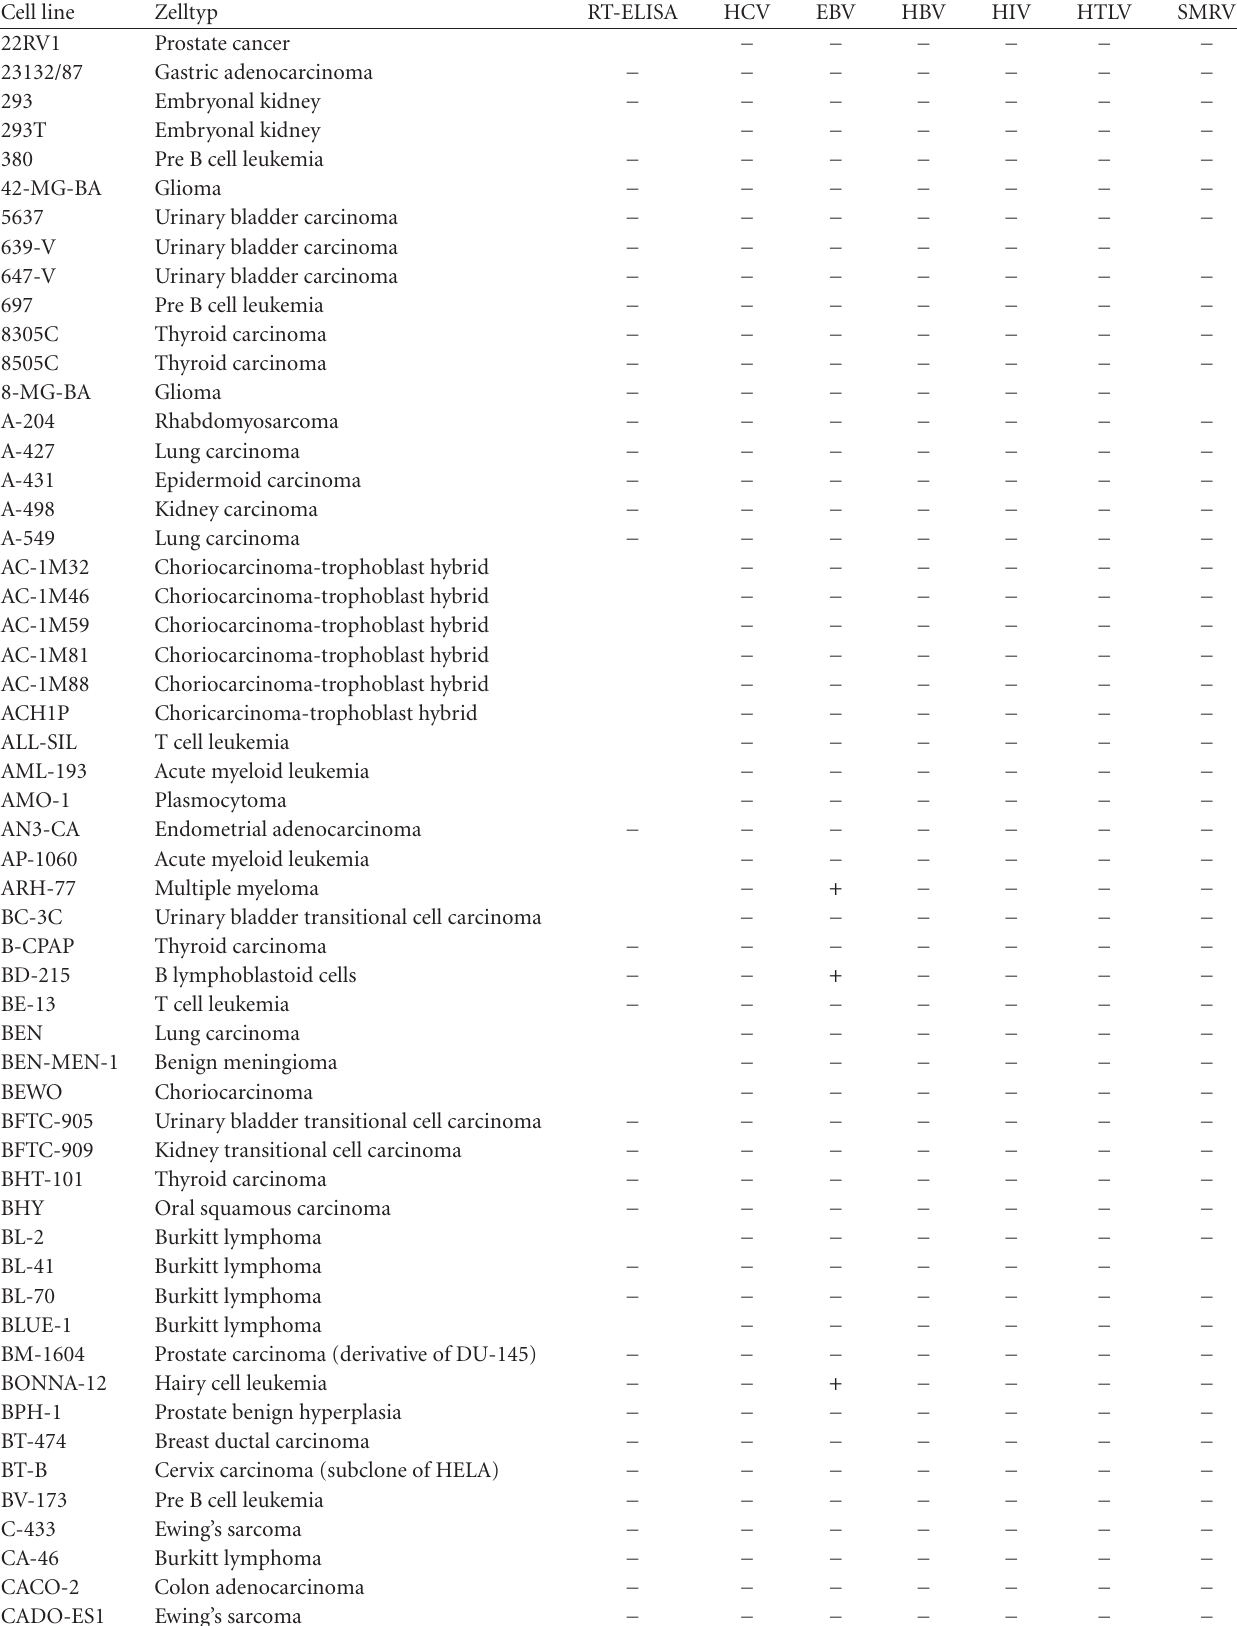
Table 3: List of cell lines tested for RT activity by ELISA, and for the presence of EBV, HBV, HCV, HIV-1, HTLV-I/-II, and SMRV. Cell line